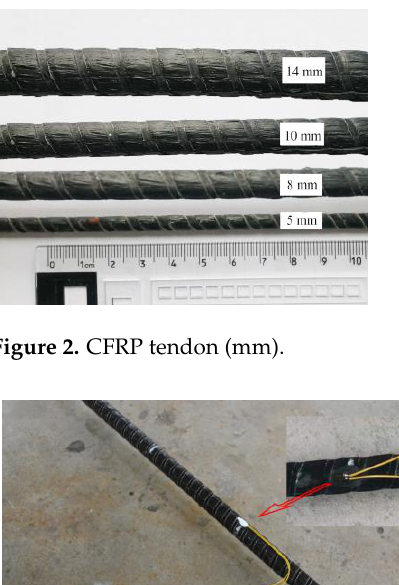
Figure 1. Bond-type anchorage (mm).